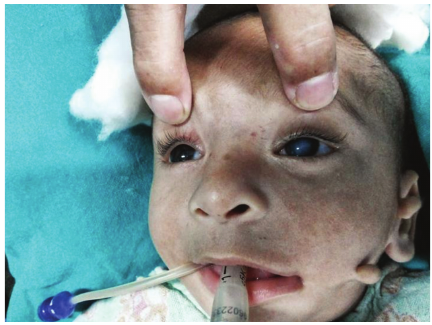
Figure 2: Child with cataract in the left eye and preauricular tag.